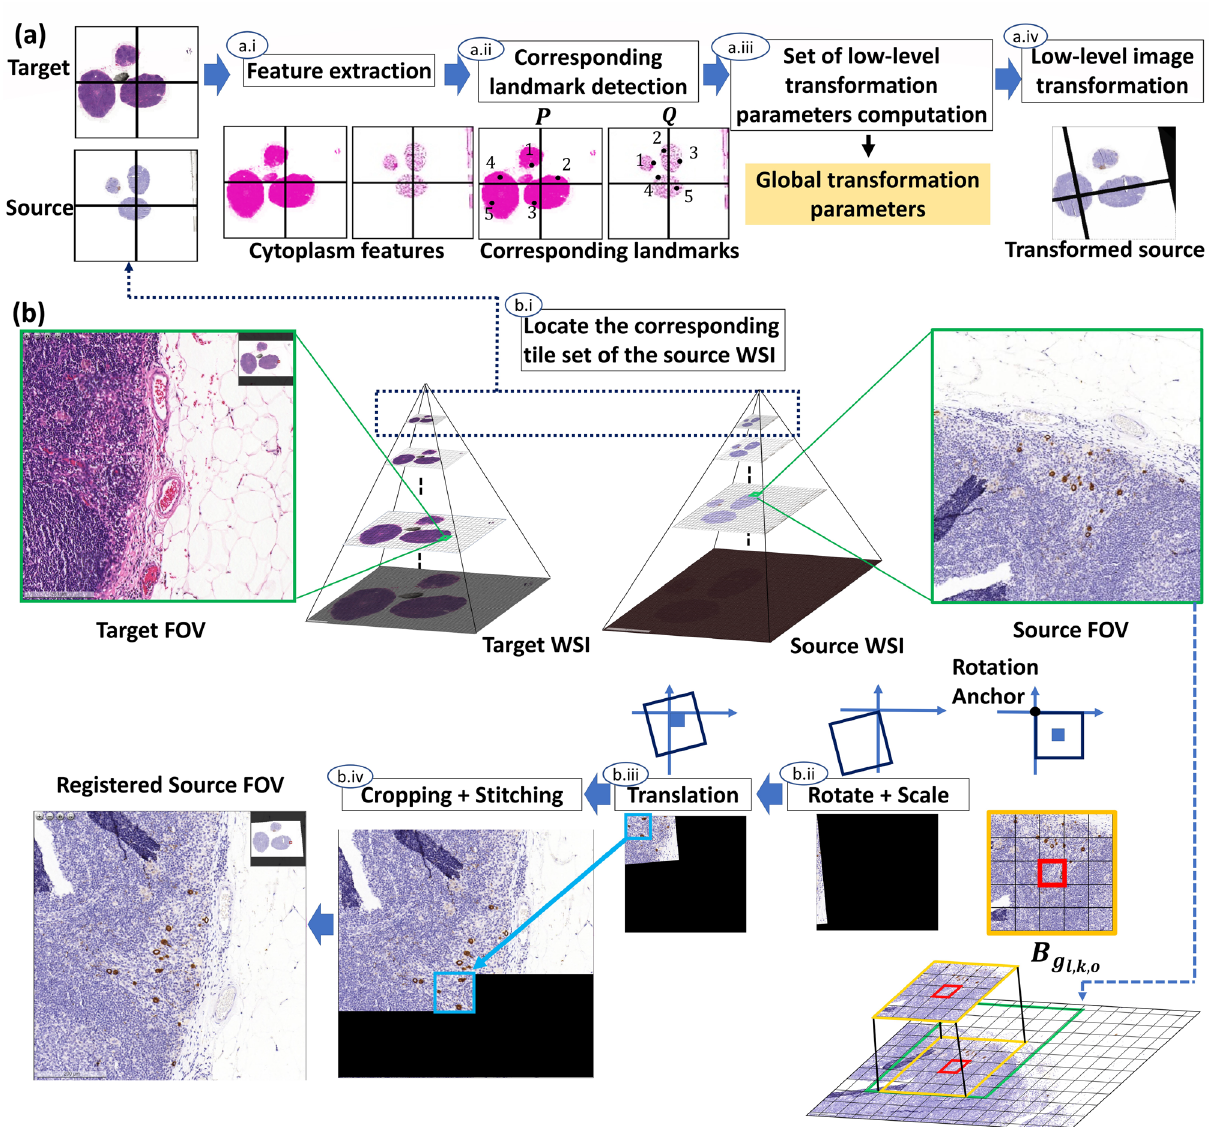
Figure 5. Flowchart of the proposed real time interactive cross staining WSI alignment framework, consisting of ( a ) a rapid global image registration module and (b) a real time propagated multi-level image registration. For (a) rapid global registration, (a.i) a stain separation model is built to extract the cytoplasm features; (a.ii) Corresponding landmarks are detected using the cytoplasm features; (a.iii) Based on the corresponding landmarks, global transformation parameters are generated; (a.iv) A global image registration result is obtained by applying the global transformation parameters onto the low-level image. For ( b ) multi-level image registration, a tile set of the source WSI corresponding to the Field of View (FOV) of the target WSI are fetched using the global transformation parameters. (b.i) The fetched tile set as the source FOV highlighted in green is used as input, and each tile is selected as the center, which is colored in red, to obtain an enlarged area highlighted in orange. After that, each enlarged area is scaled and then rotated clockwise by the rotation anchor as center. (b.ii) The top left tile highlighted in blue is translated; (b.iii) The tile is then cropped and stitched into the registration output image; (b.iv) The registered source FOV is layers from low to high magnification, where i and j represent the column and row number of a tile in level l , respectively, and the unit of the tile size is m × m , where m = 256 in this study. Low-level target and source tile- I s I l < = ( 2 m ) 2 . I t images I t low , I s low are extracted from target and source WSIs at level l low , and l low = low and low are used for the rapid global image registration process. (cid:31) To obtain the global transformation parameters and low-level image registration result, low-level image registration process comprises four parts as shown in Fig. 5a. (1) Using colour deconvolution technique with an orthonormal transformation matrix, stain separation is performed on the low-level target and source tile-images to extract the cytoplasm features of the target and source. (2) Corresponding landmark detection is applied to the